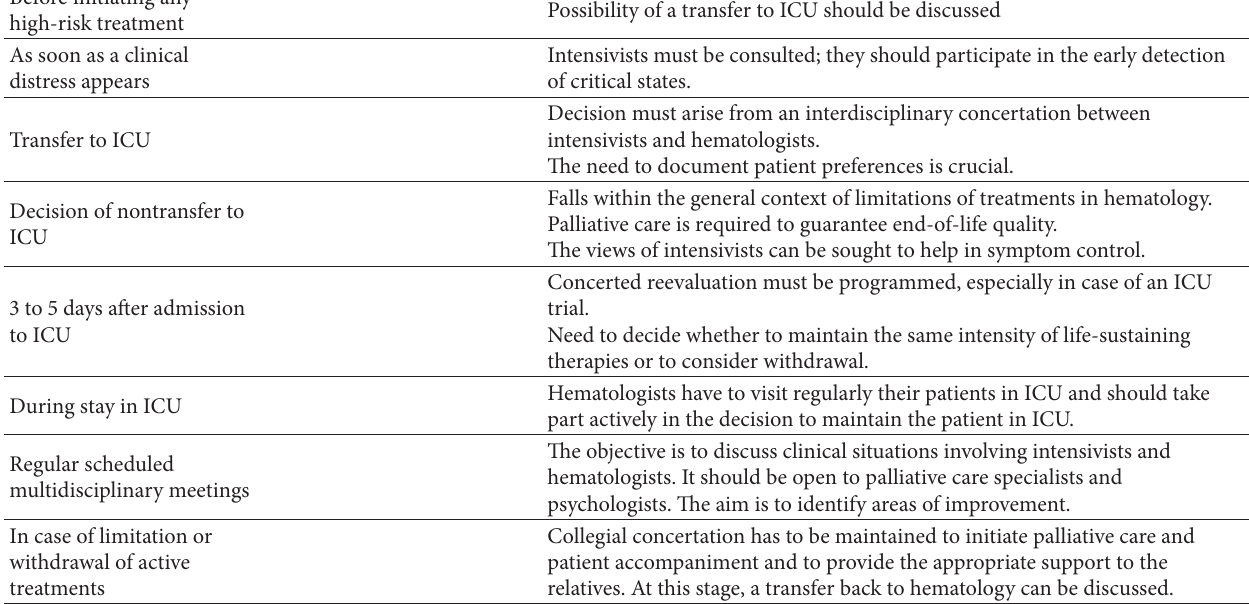
Table 1: Multistep decision-making